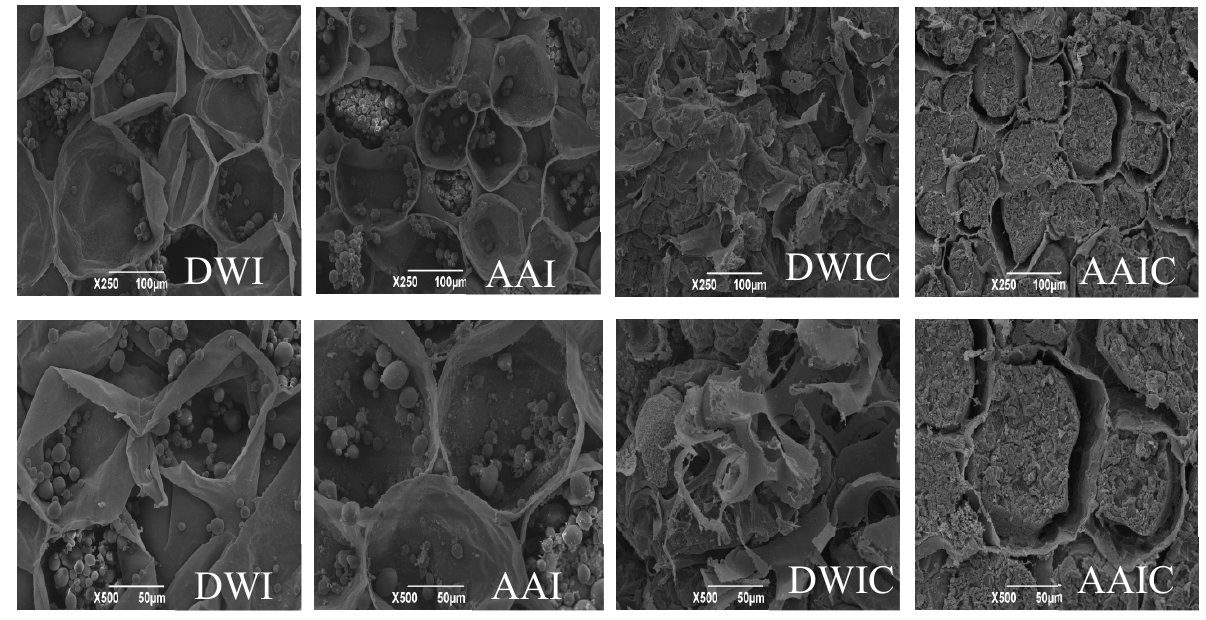
Figure 2. SEM images of arrowhead bulb slices under different treatments. DWI: distilled water immersion for 15 h; AAI: 0.6% acetic acid immersion for 15 h; DWIC: cooked DWI; AAIC: cooked AAI. Each treated sample was observed at 250× and 500× magnification.